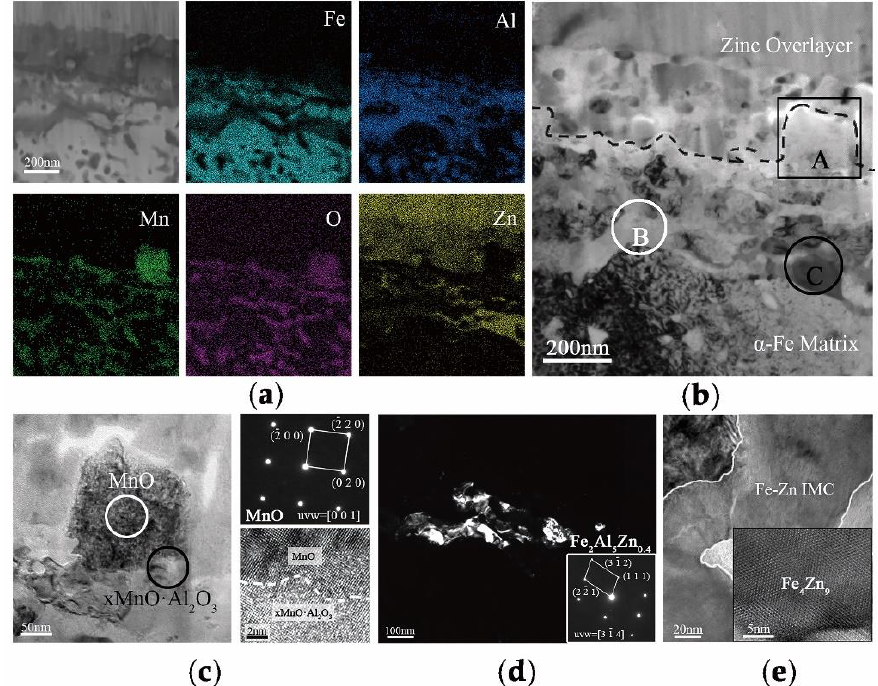
Figure 3. ( a ) STEM cross-sectional elemental maps of the coating / substrate interface of the galvanized 3 Mn steel annealed under the 283 K ( + 10 ◦ C) DP process atmosphere. ( b ) TEM micrograph of the area shown in ( a ). ( c ) Enlargement of the area corresponding to zone A in ( b ). ( d ) Dark filed image and di ff raction pattern of the inhibition layer corresponding to zone B in ( b ). ( e ) Enlargement and lattice image of the area corresponding to zone C in ( b ).